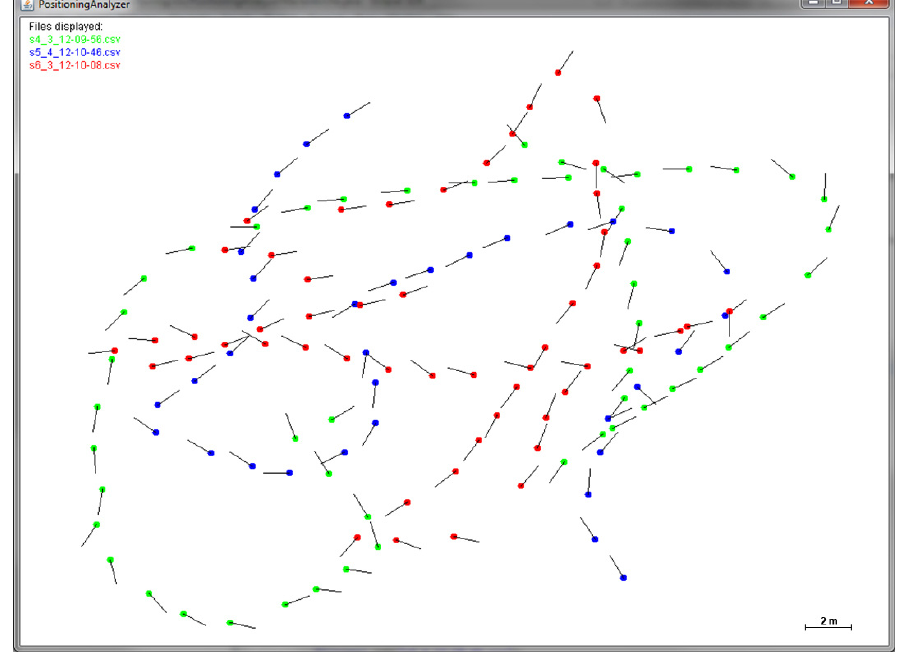
Figure 3. Visualization of movement data from three different smartphone users (green, blue, and red) derived from the internal sensor data via the Android API. The dots symbolize the GPS/GNSS location of the smartphone user. The lines point towards the corresponding movement direction of the